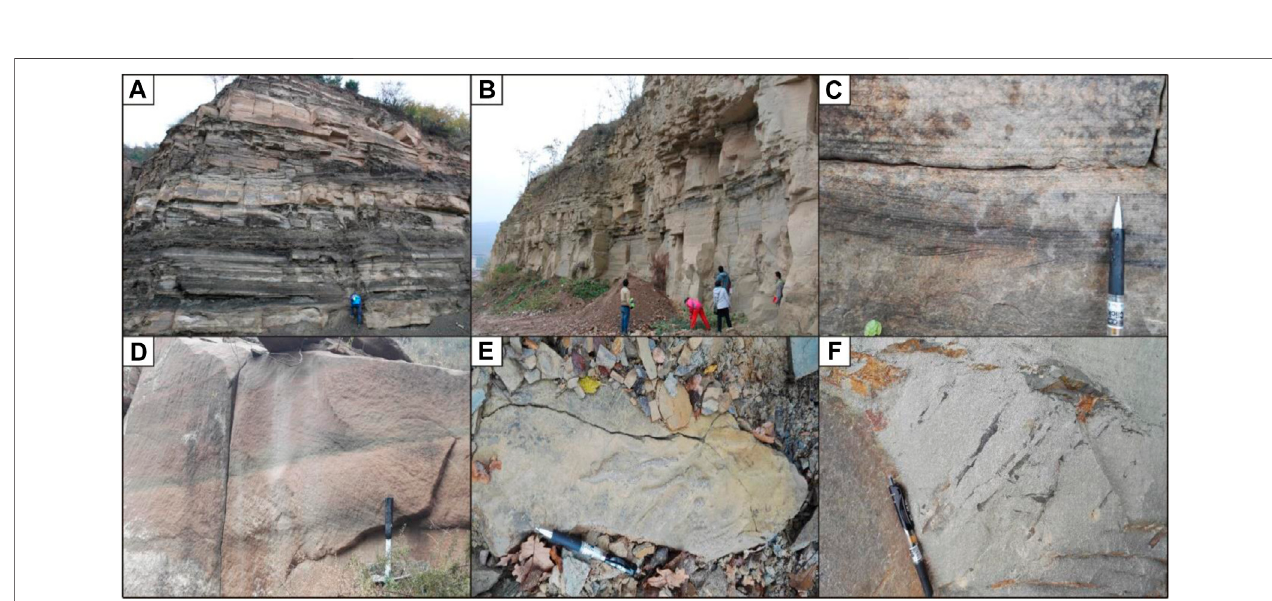
FIGURE 2 | Pro fi le photos of Yangchang formation in Ordos Basin. (A) Sand-mud interlayer in Ch-7 formation, located in Xunyi; (B) Mudstone interlayer in Ch-6 Formation, located in Xunyi; (C) Parallel bedding in Ch-7 Formation, located in Yanchang; (D) Oblique bedding in Ch-6 Formation, located in Jiaxian; (E) Impression in Ch-7 Formation, located in Yijun; (F) Mud gravel in Ch-6 Formation, located in Lingwu.